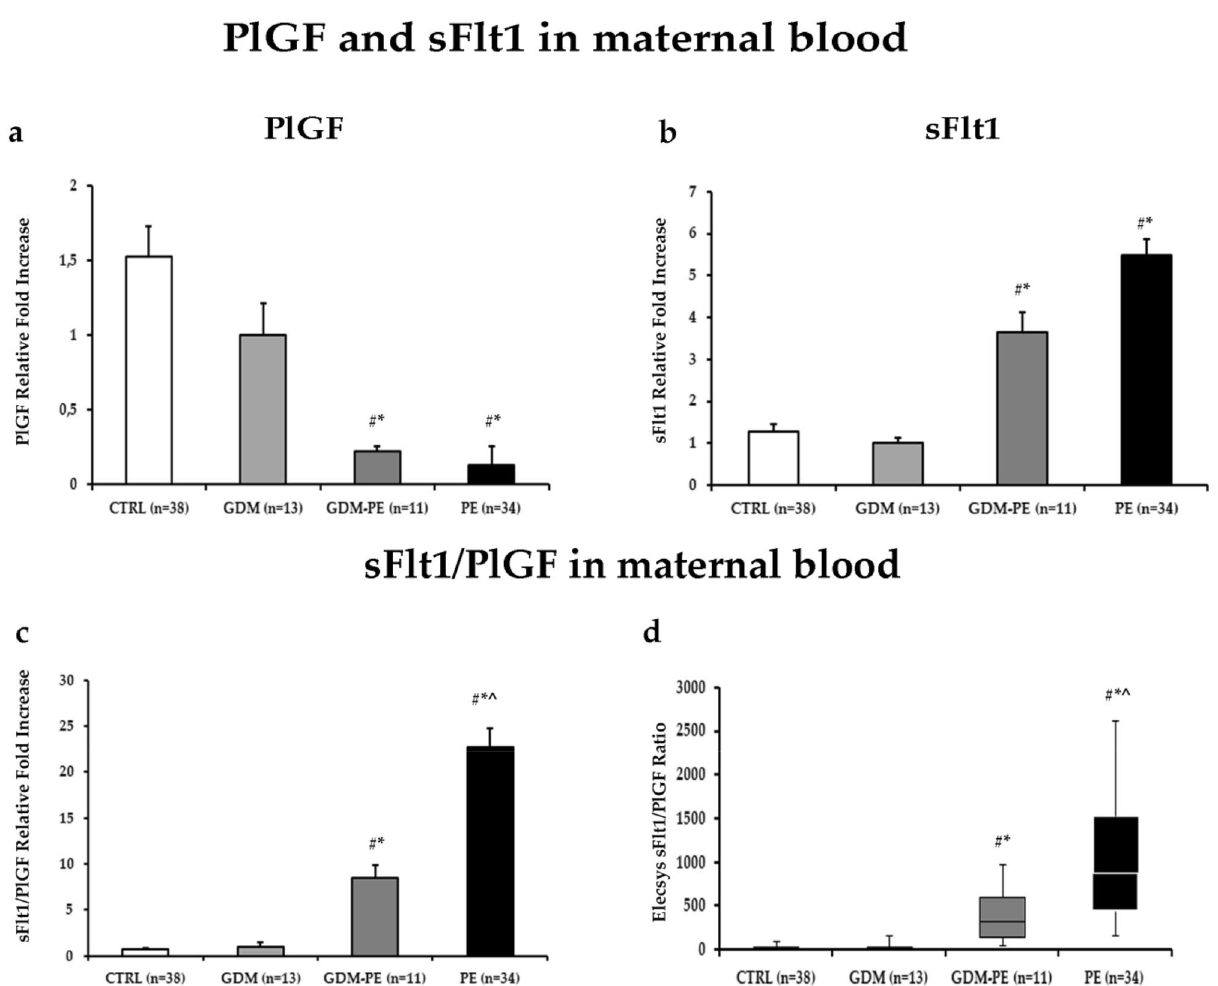
Figure 1. Maternal Blood PlGF, sFlt1 and sFlt1/PlGF ratio in CTRL, GDM, GDM-PE and PE pregnancies. ( a ) PlGF and ( b ) sFlt1, ( c ) sFlt1/PlGF ratio relative to fold increases and ( d ) boxplot of calculated sFlt1/PlGF ratios in CTRL, GDM, GDM-PE and PE patients as assessed by Elecsys methodology. Statistical significance has been considered as p < 0.05. # P < 0.05 versus CTRL; * P < 0.05 versus GDM; § P < 0.05 versus PE; ^ P < 0.05 versus